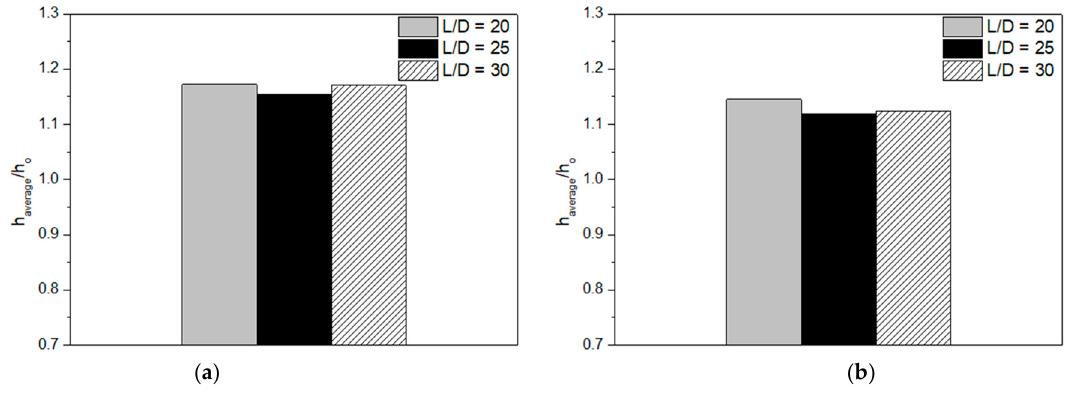
Figure 12. h average /h o for different hole row-to-row distance cases: ( a ) M = 1.0; and ( b ) M = 2.0.